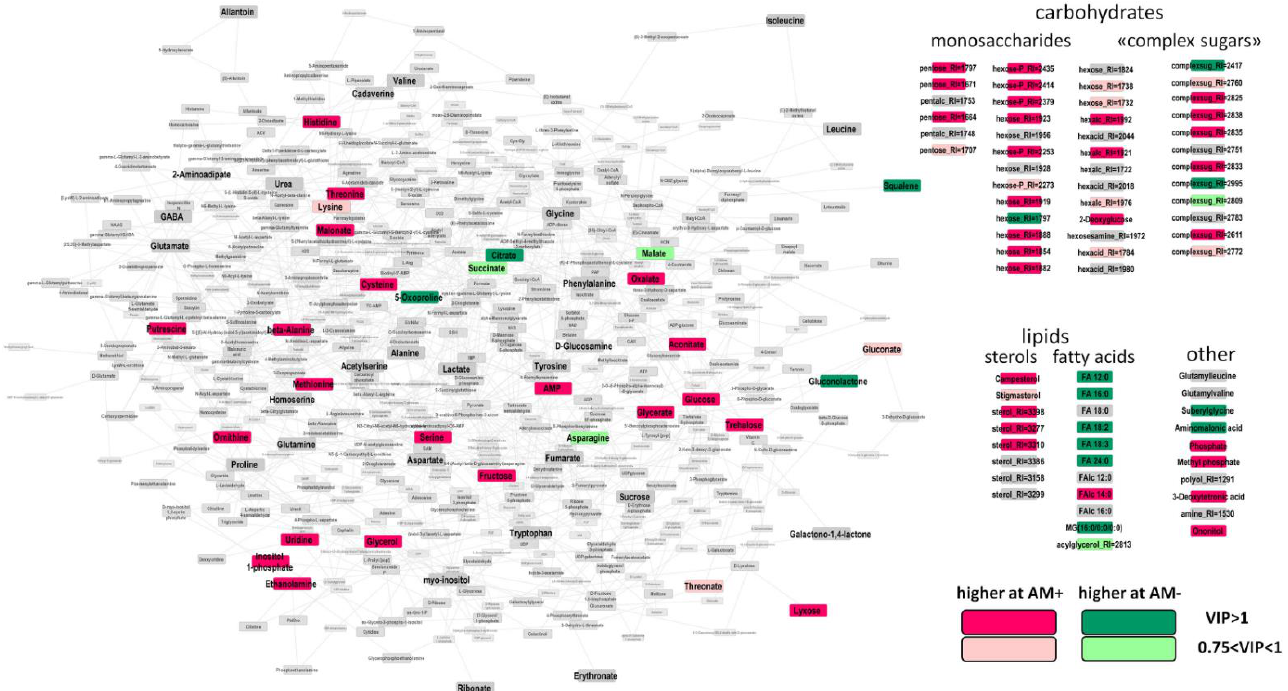
Figure 4. Visualization of differentially accumulated metabolites (DAMs) in response to mycorrhization at 24 DAS revealed through OPLS-DA. Nodes — metabolites; edges — reactions extracted from KEGG database.